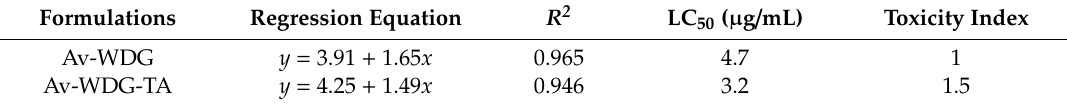
Table 1. Biological activities of Av-WDG and Av-WDG-TA against aphids ( Myzus persicae L.).